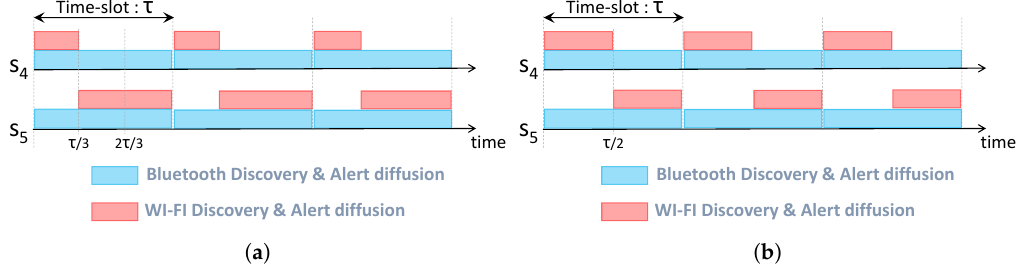
Figure 6. Alert diffusion schedule inside Room 2. ( a ) Before energy balance; ( b ) After energy balance.